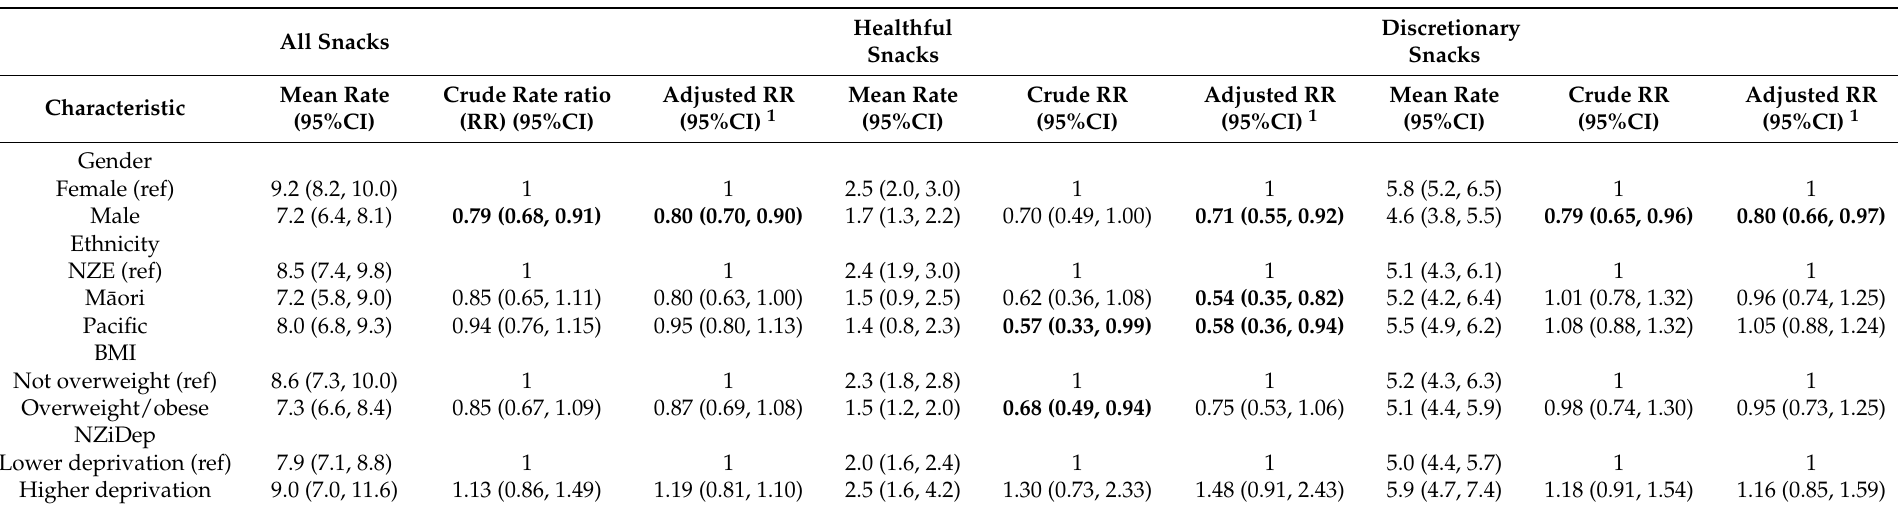
Boldface indicates statistical significance. 1 Mutually adjusted for gender, ethnicity, BMI and